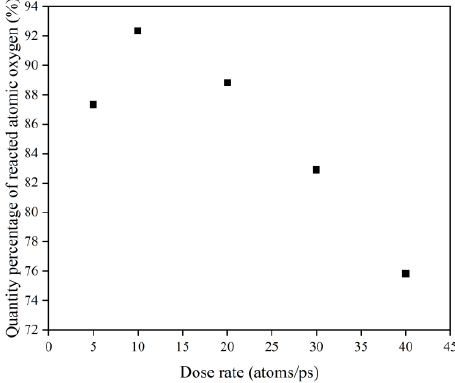
Figure 17. Quantity percentage of reacted atomic oxygen.